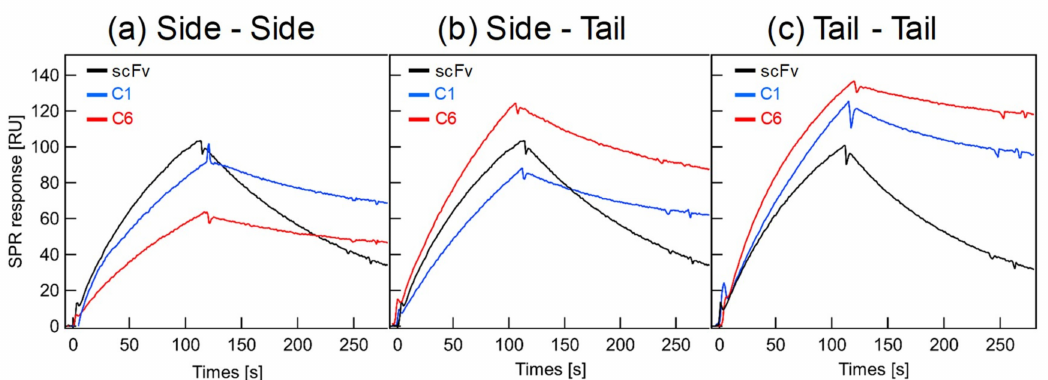
Figure 6. SPR sensorgrams for the binding of scFv (black curve), scFv dimer with C1 linker (blue curve), and scFv dimer with C6 linker (red curve), with respect to the immobilized EGFR (RU: 2605~2833). ( a ) side–side scFv at the concentration of 140 nM (C1) and 110 nM (C6), ( b ) side–tail dimers at the concentration of 115 nM (C1) and 130 nM (C6), ( c ) tail–tail dimers at the concentration of 140 nM (C1) and 165 nM (C6). HK19-0K was applied for monomeric scFv at the concentration of 125 nM in ( a , b ), and LK103-0K scFv at the concentration of 125 nM was applied in ( c